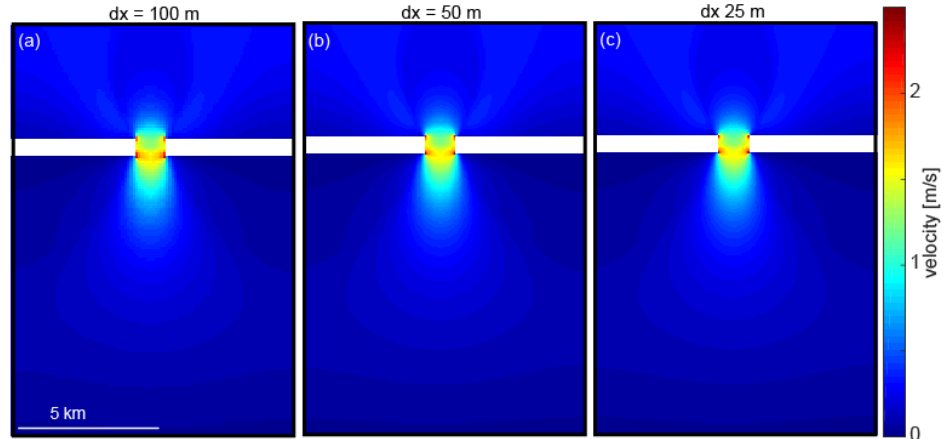
Figure 4. Sensitivity analysis reproducing the peak ebb flow for the idealized basin geometry with a depth of 10 m (as in Figure 2f) using a spatial discretization (dx) equal to ( a ) 100 m; ( b ) 50 m; and ( c ) 25 m.